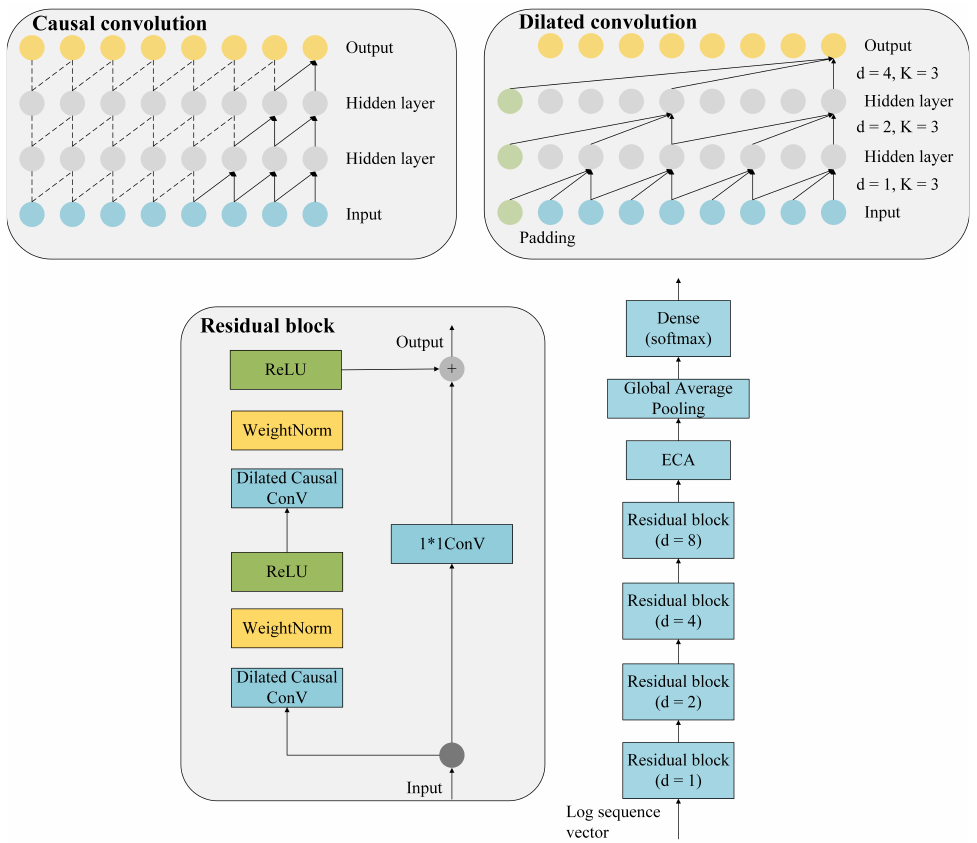
Figure 4. The model architecture has four essential components: causal convolution, dilated convolu- tion, enhanced residual block, and efficient channel attention module. The residual block consists of two layers of